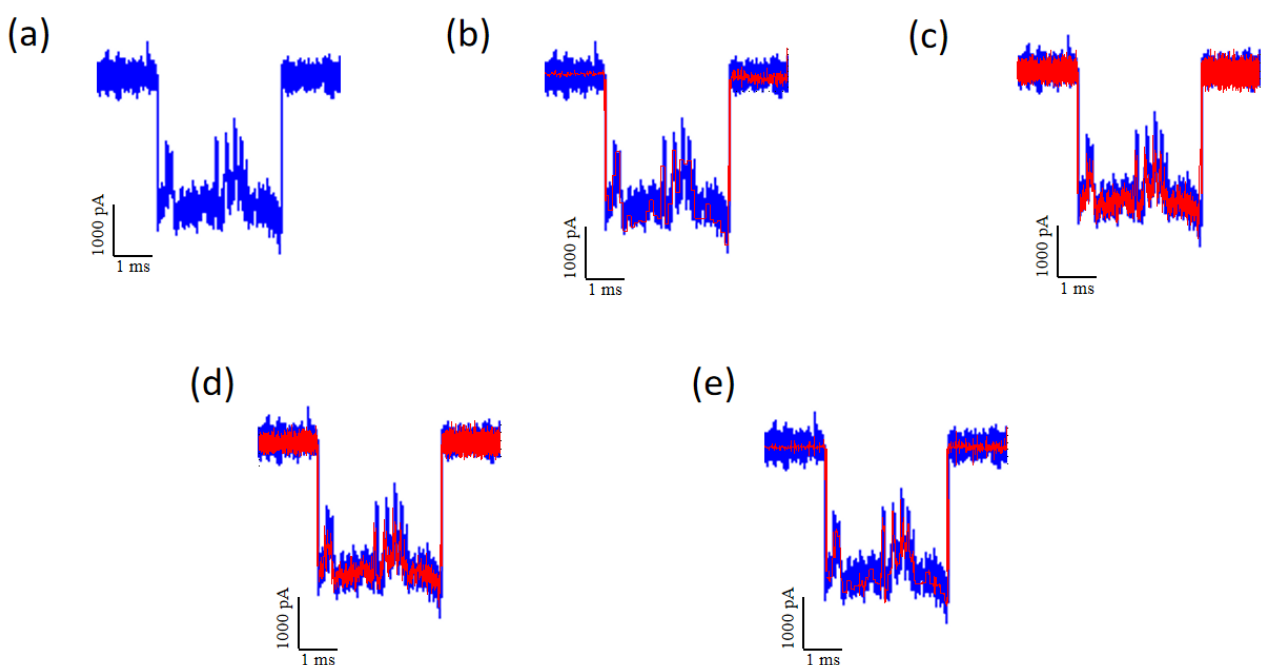
Figure 4. Wavelet noise reduction effect: ( a ) original signal; ( b ) wavelet decomposition and recon- struction method; ( c ) hard threshold method; ( d ) soft threshold method; ( e ) wavelet mode maxima method.